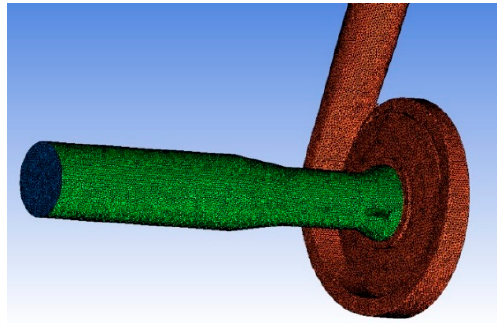
Figure 4. Computational meshes.